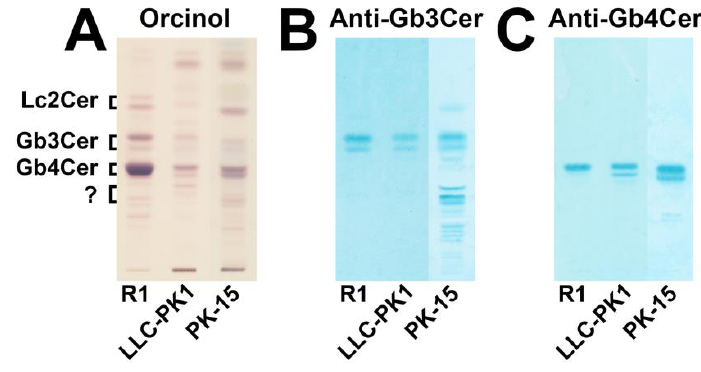
Figure 1. Orcinol stain ( A ) and antibody-mediated immunochemical detection of thin-layer chromatography (TLC) separated globo-series Shiga toxin (Stx) receptor glycosphingolipids (GSLs) Gb3Cer ( B ) and Gb4Cer ( C ) in the neutral GSL preparations of the porcine LLC-PK1 and PK-15 renal epithelial cell lines. The applied GSL quantities correspond to 2 × 10 6 LLC-PK1 and 1 × 10 6 PK-15 cells for the orcinol stain ( A ) and to 5 × 10 5 LLC-PK1 and PK-15 cells for the anti-Gb3Cer ( B ) and anti-Gb4Cer overlay assay ( C ). R1: 20 µg ( A ), 2 µg ( B ), and 0.2 µg ( C ) of neutral GSLs from human erythrocytes served as reference.